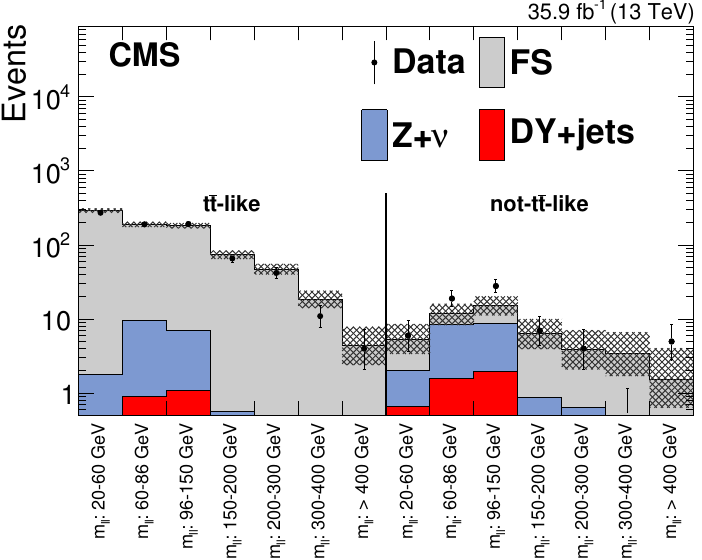
Figure 5 . Results of the counting experiment of the edge search. For each SR, the number of observed events, shown as black data points, is compared to the total background estimate. The hashed band shows the total uncertainty in the background prediction, including statistical and systematic sources.